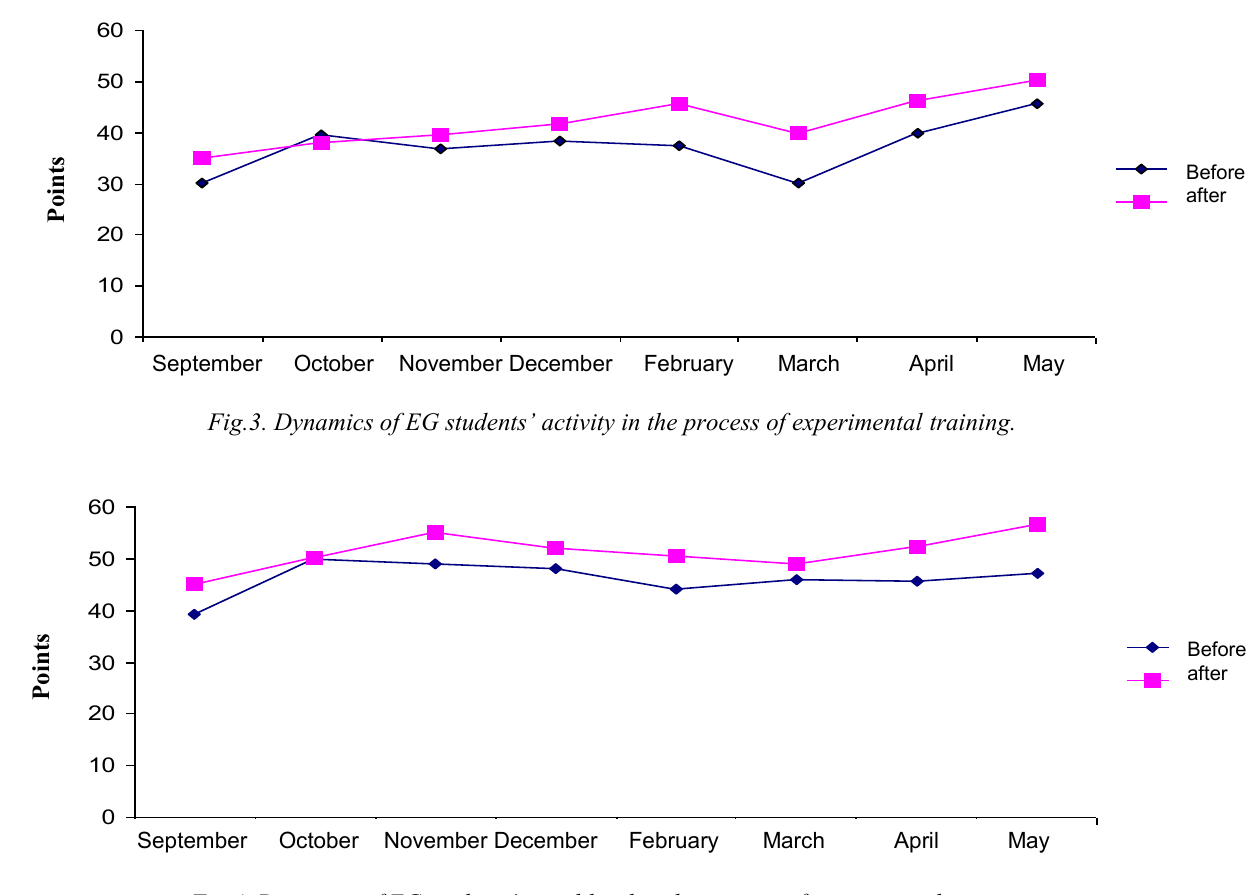
Fig.4. Dynamics of EG students’ mood level in the process of experimental